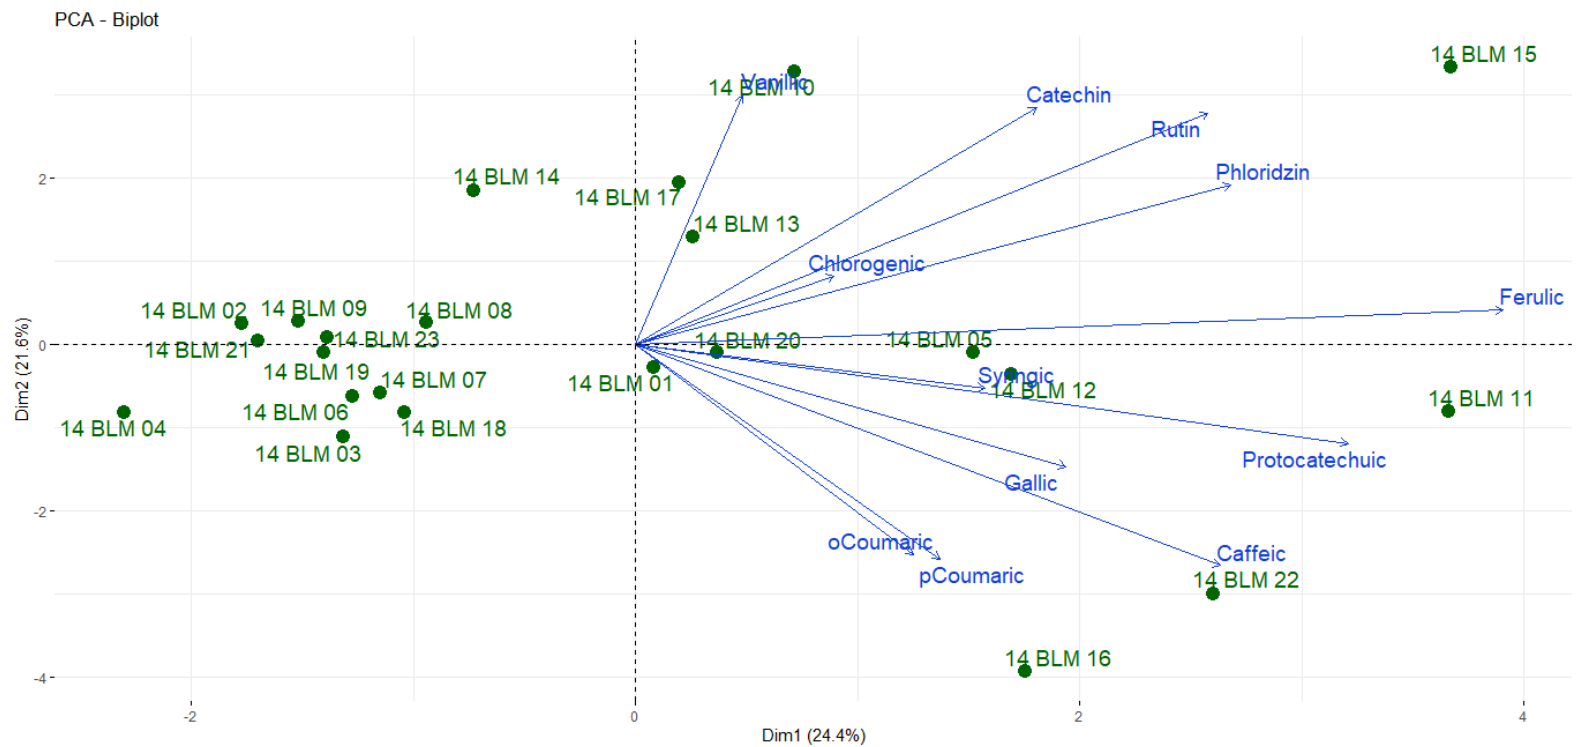
Figure 2. Distribution of plum genotypes according to phenolic compounds.